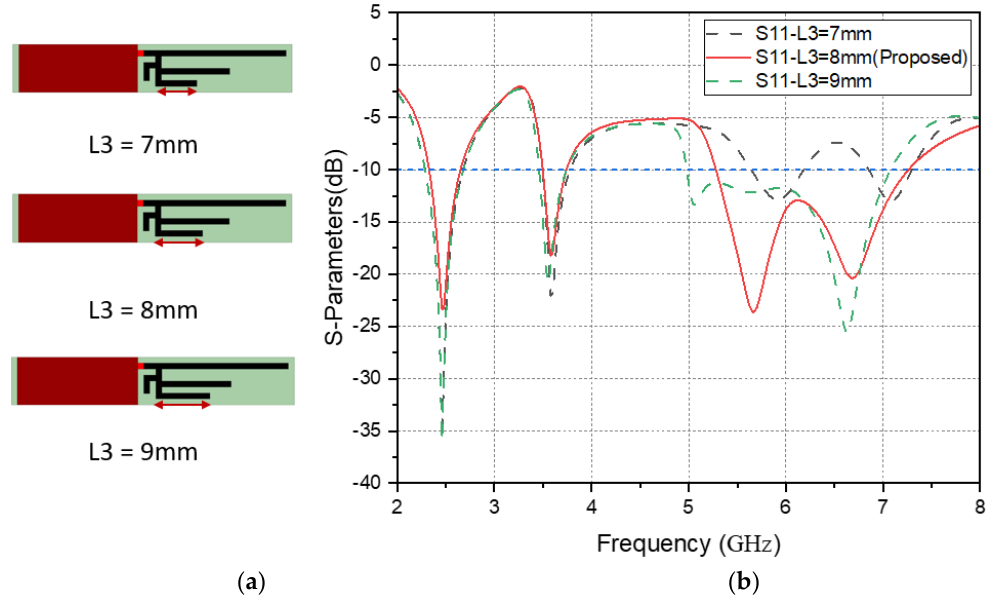
Figure 6. ( a ) Schematic diagram of L3 length variation of Ant. 1, ( b ) reflection coefficient (|S11|) of L3 length variation.